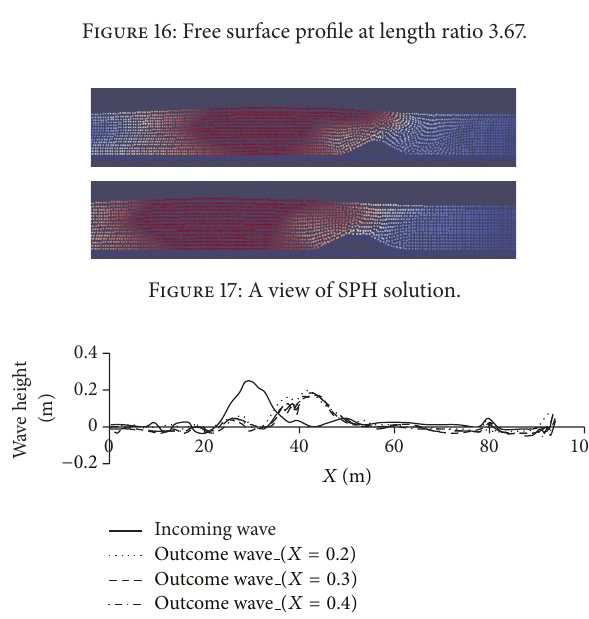
Figure 18: Simulated free surface profiles at different distances between breakwaters.